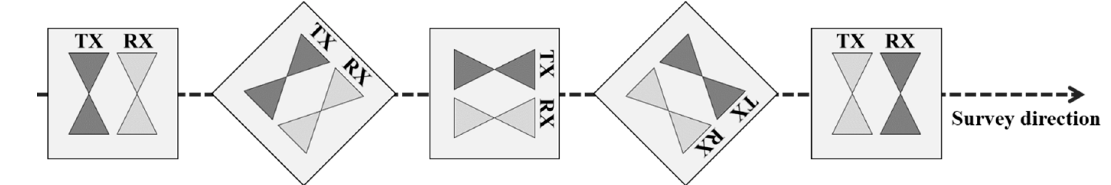
Figure 3. Simplified sketch of the survey geometry. TX is the transmitter, and RX is the receiver, while the survey line is indicated.